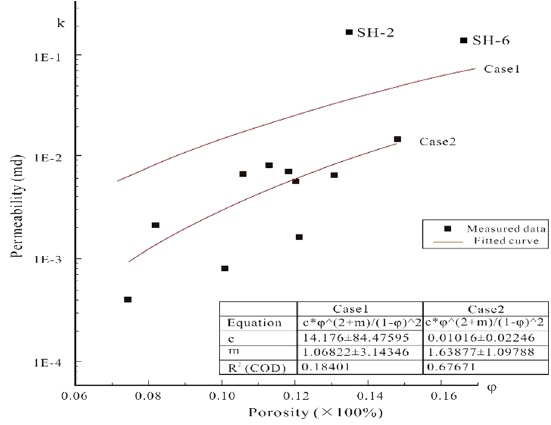
Fig. 3 Fitting curve of coal porosity and permeability based on the extended KC